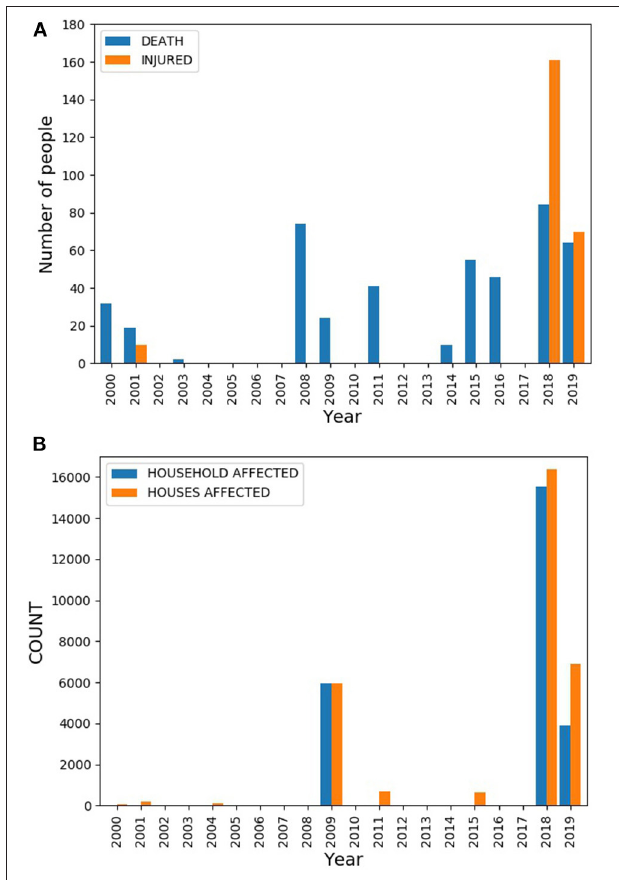
FIGURE 3 | (A) The annual number of deaths and injuries and (B) the annual number of people affected and houses destroyed and damaged by weather-related disasters.